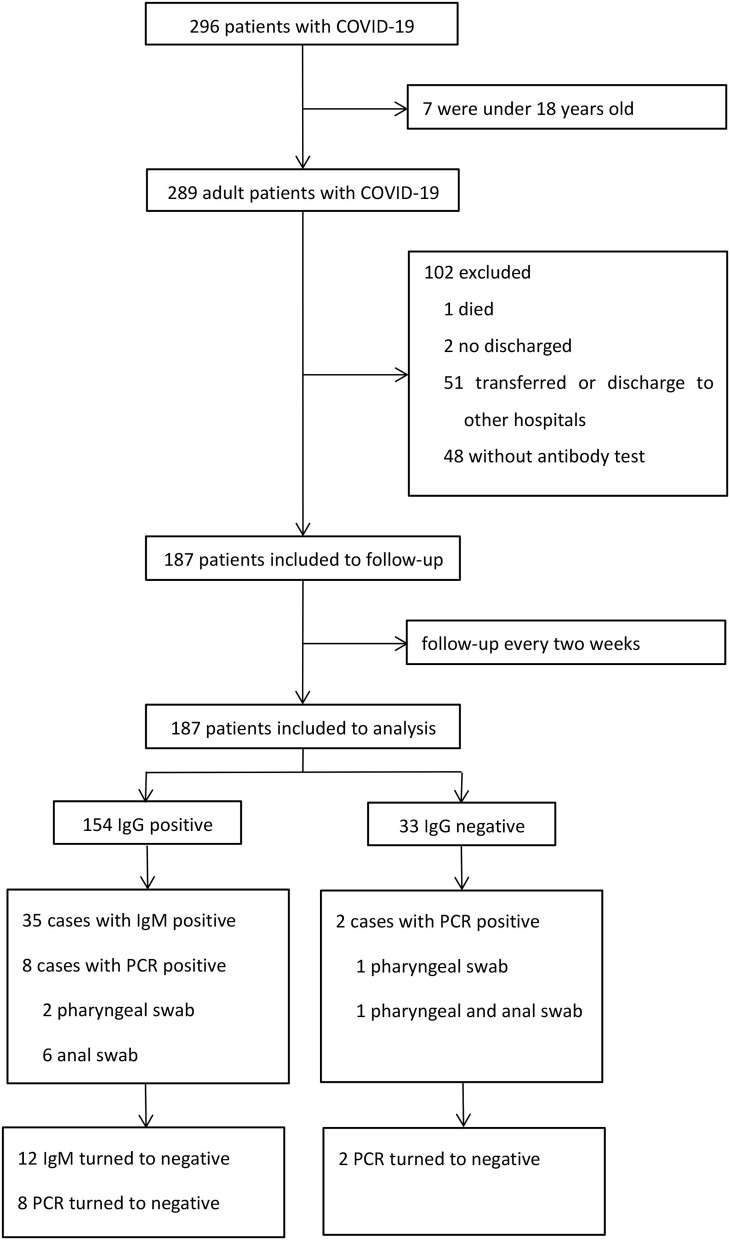
Flow of patients through the study.